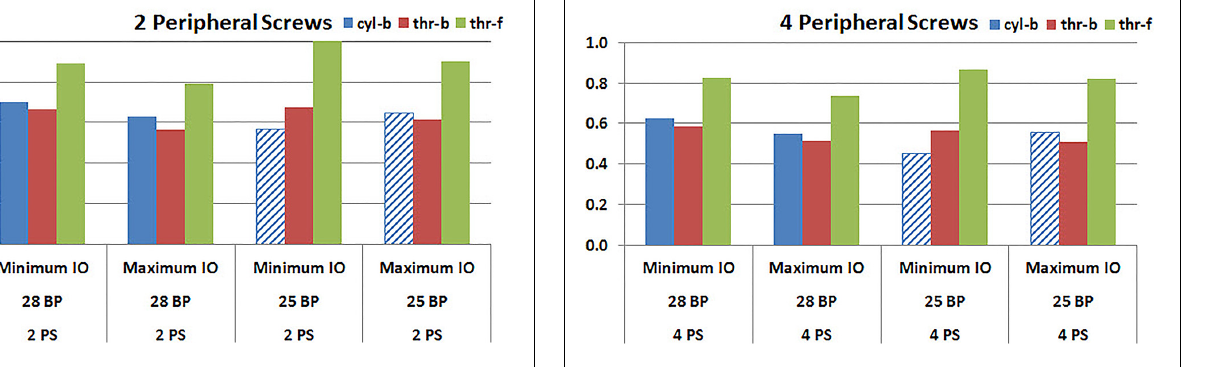
FIGURE 10 | Interfacial micromotion results using Minimum and Maximum inferior offset (Minimum IO and Maximum IO); 28 mm and 25 mm baseplates (28 BP and 25 BP), with four peripheral screws. The patterned bars represent the predictions where the primary trend (maximum inferior offset resulted in reduced micromotion) was